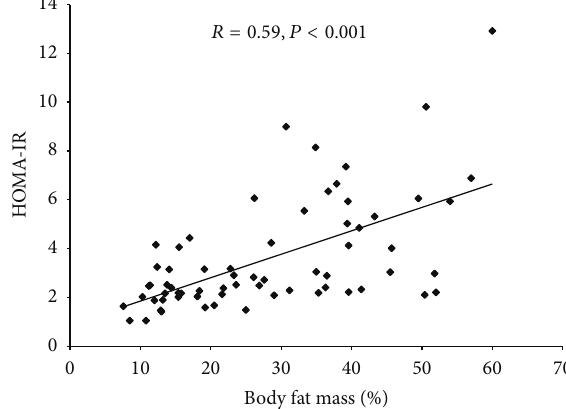
Figure 2: Scatter plot of body fat mass and HOMA-IR in DMD/BMD patients. HOMA-IR, homeostasis model assessment- insulin